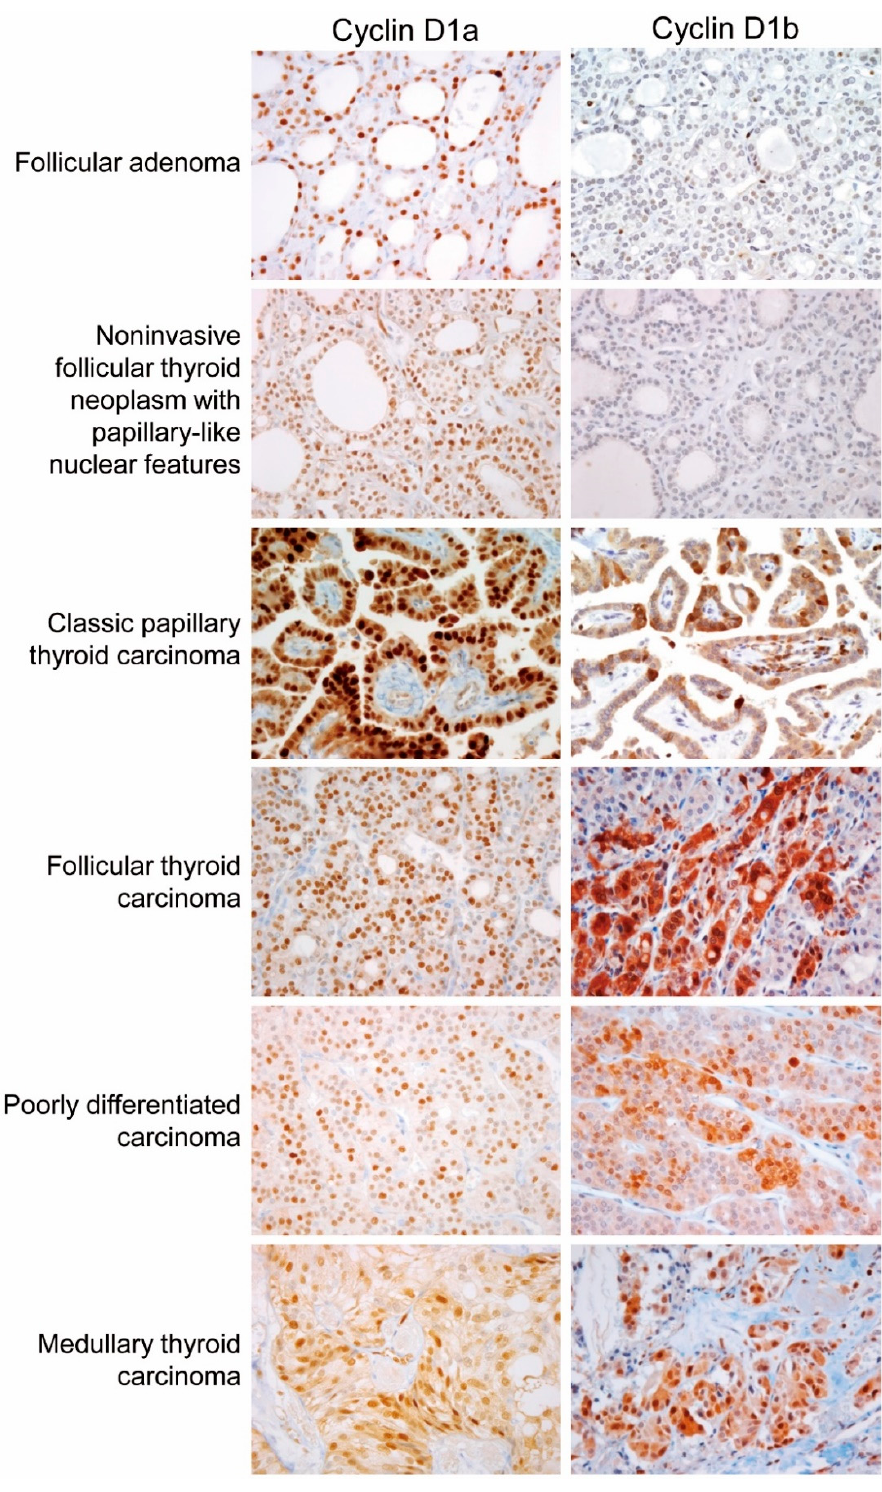
Figure 3. Immunohistochemical staining of cyclin D1a and cyclin D1b in various types of thyroid tumors (×400).